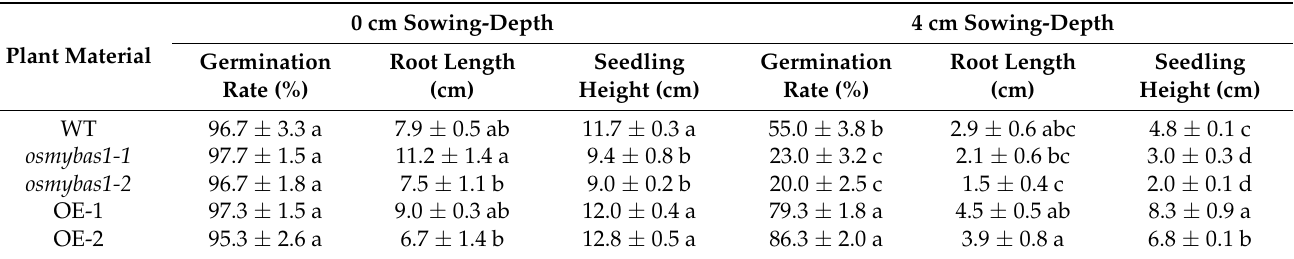
Table 1. Germination rates, root lengths and seedling heights of wild-type, OsMYBAS1 - overexpressing plants and osmybas1 mutants under different sowing depths.